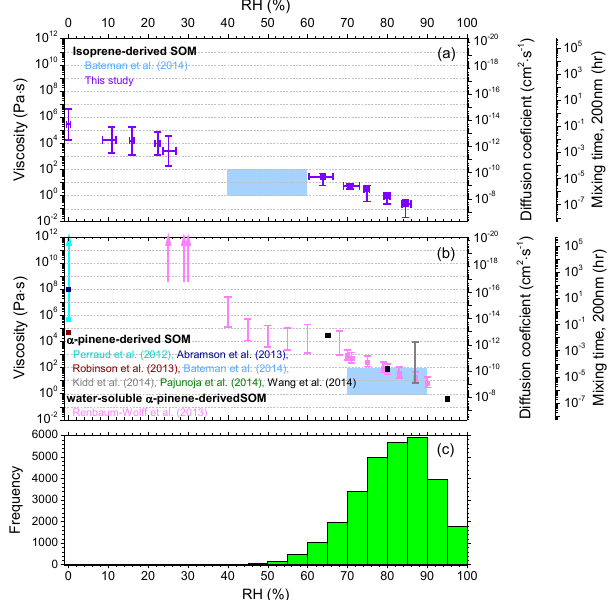
Figure 8. (a) Collection of viscosities of isoprene-derived SOM particles from this study (purple) and Bateman et al. (2014) (light blue). Viscosities of isoprene-derived SOM from this study are taken from values shown in Figs. 6c and 7c. (b) Viscosities of α - pinene-derived SOM particles from literature (Perraud et al., 2012, cyan; Abramson et al., 2013, dark blue; Robinson et al., 2013, brown; Bateman et al., 2014, light blue; Kidd et al., 2014, grey; Pajunoja et al., 2014, green; and Wang et al., 2014, black) and viscosities of water-soluble α -pinene-derived SOM particles from Renbaum-Wolff et al. (2013a) (pink). The right y axes present cal- culated diffusion coefficients of organic molecules in SOM and calculated mixing times within 200nm particles due to bulk dif- fusion. Diffusion coefficients were calculated using the Stokes– Einstein relation and mixing times were calculated using Eq. (2) (see Sect. 4.3). (c) The average frequency distributions of RH from eight stations in the Amazon Basin (Tabatinga, Barcelos, Itaituba, Monte Dourado, Iquitos, Lábrea, Manicoré, and Manaus). Fre- quency distributions of RH from the individual stations are shown in Fig.